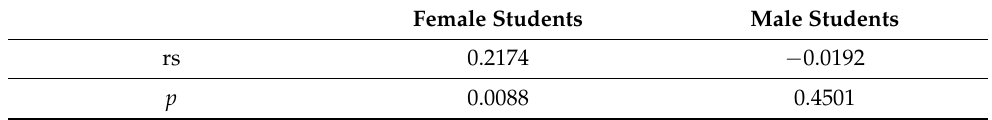
Table 3. Results of the Spearman correlation test—correlation between age and sten scale.